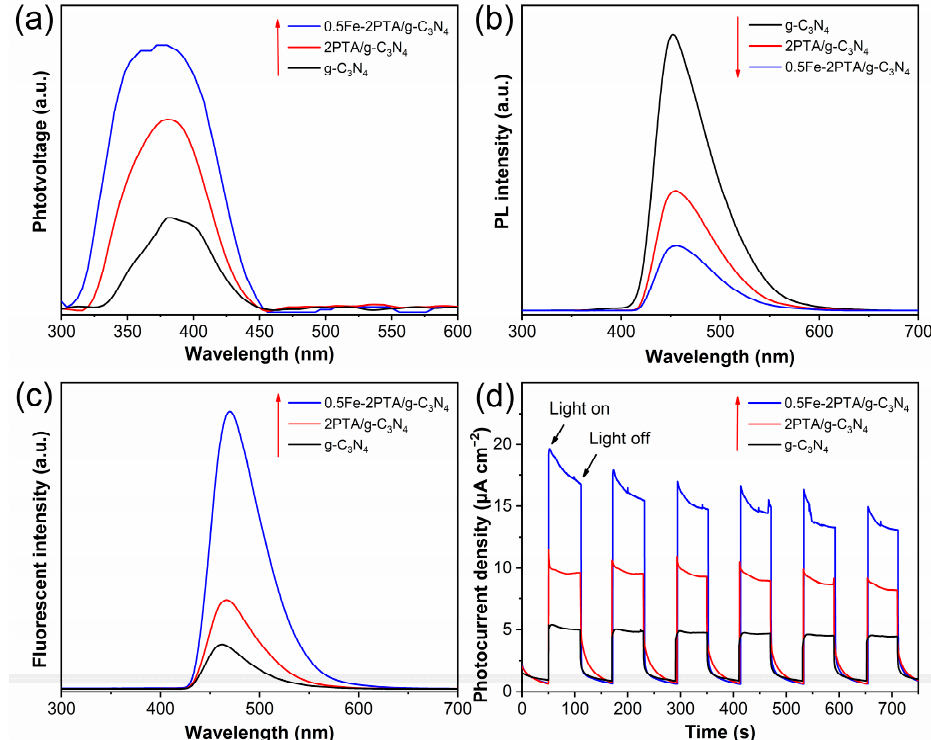
Figure 5. Photophysical and photochemical properties of samples. ( a ) SS-SPS responses in air. ( b ) PL spectra. ( c ) Fluorescence spectra related to the formed •OH amounts after irradiation for 1 h under irradiation with visible light. ( d ) Photocurrent response. (The arrows represent the changing tendency of the response signals.)